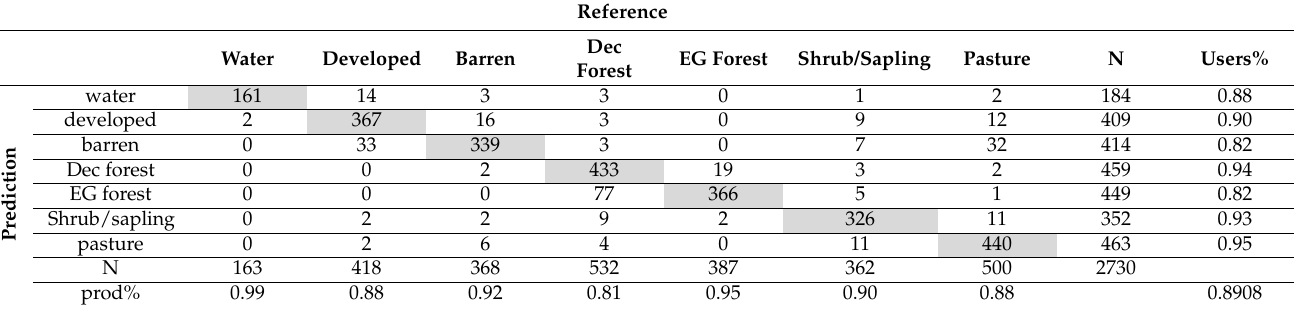
Table 1. Confusion matrix of correctly and incorrectly classified sites across the five-county focal region. Values represent the number of 3 m radius circles where the majority of classified cells matches (grey diagonal) or does not match (off diagonal cells) the actual land cover as determined from visually inspecting NAIP and VBMP imagery. Dec forest is deciduous and mixed forest, and EG forest is evergreen forest.